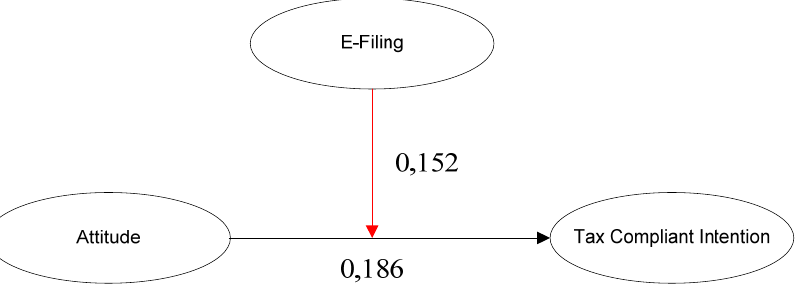
Figure 4. Moderation Effect of e-Filing on the Relationship between Attitudes on Tax Compliant Intention. Source: Research Data (2020).